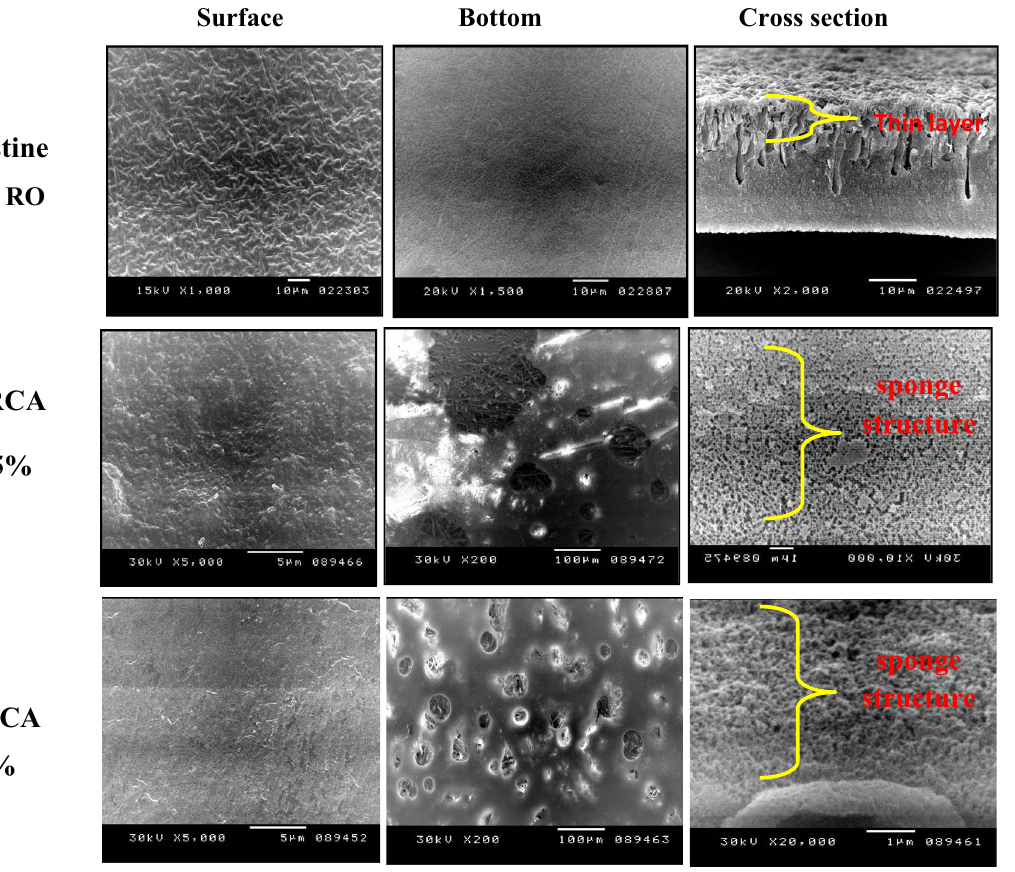
Figure 7. SEM images of surface, bottom and cross section of NRCA membranes compared with pristine CA-RO